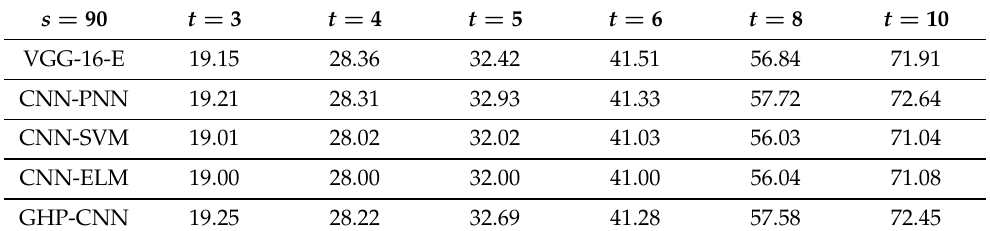
Table 6. Comparison of test time for each algorithm.